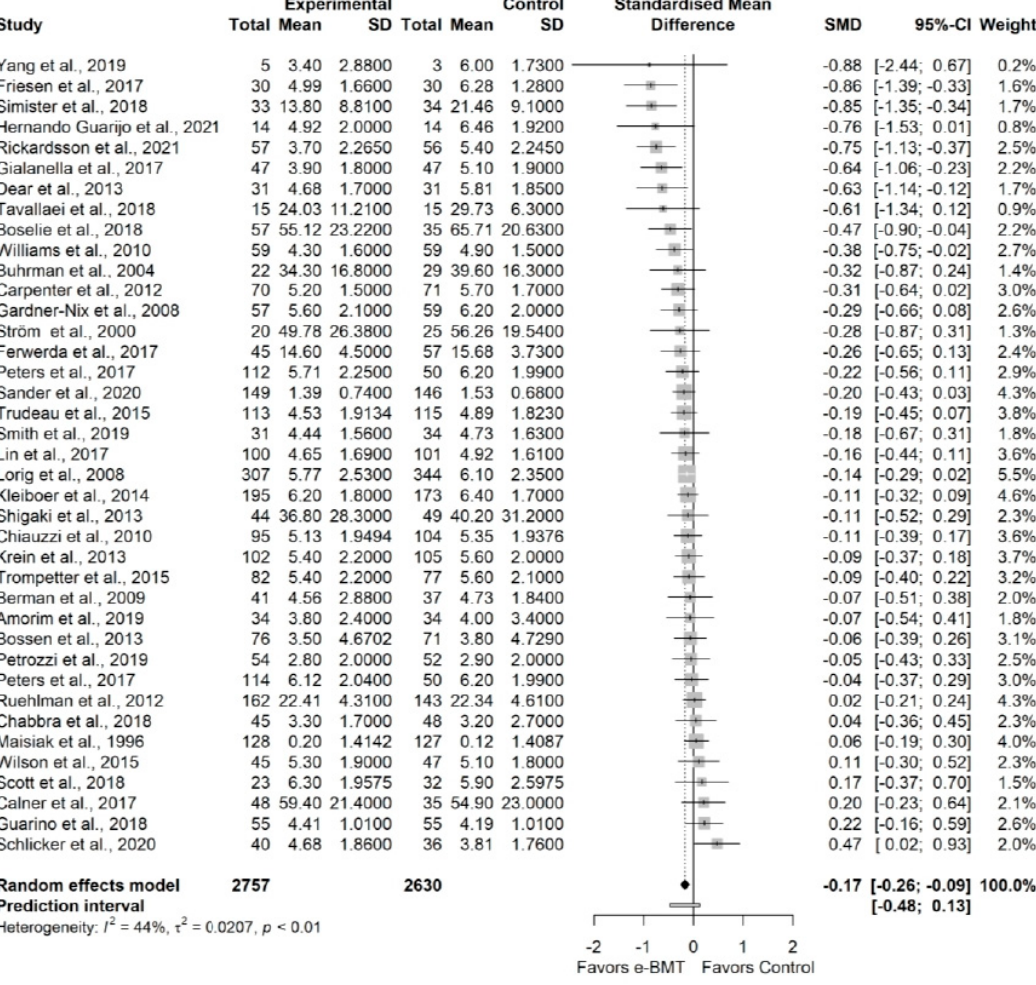
Figure 1. Sensitivity analysis of the pain intensity variable for online behavioral techniques against usual care or waiting list. The forest plot summarizes the results of included studies (sample size, mean, standard deviation (SD), standardized mean differences (SMDs), and weight). The small boxes with the squares represent the point estimate of the effect size and sample size. The lines on either side of the box represent a 95% confidence interval (CI).